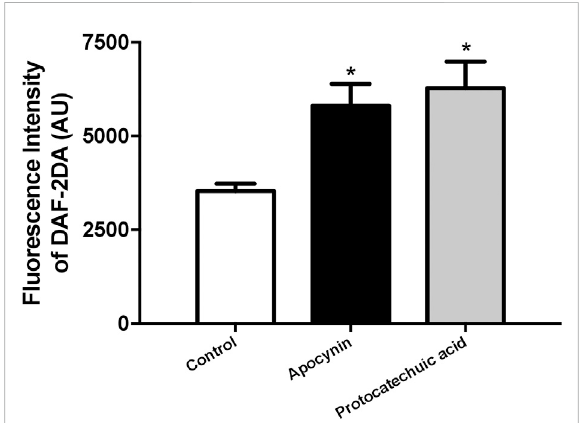
FIGURE 7 Nitric oxide (NO) concentration, in arbitrary units, in human umbilical vein endothelial cells (HUVEC). Fluorescence intensity was detected by NO-sensitive probe 4,5-diamino fl uorescein diacetate (DAF-2DA) in cells unstimulated (Control, white bars) or stimulated (100 μ mol/L) with apocynin (black bars) or protocatechuic acid (grey bars). Values represent the mean ± SEM of the results, n = 4. * p < 0.05 Apocynin and Protocatechuic acid vs.